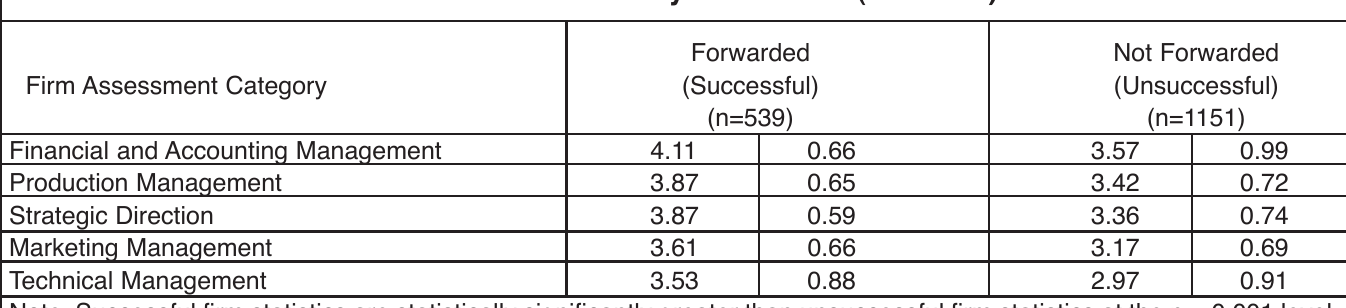
Firm Assessment Statistics by Forwarded (Success)